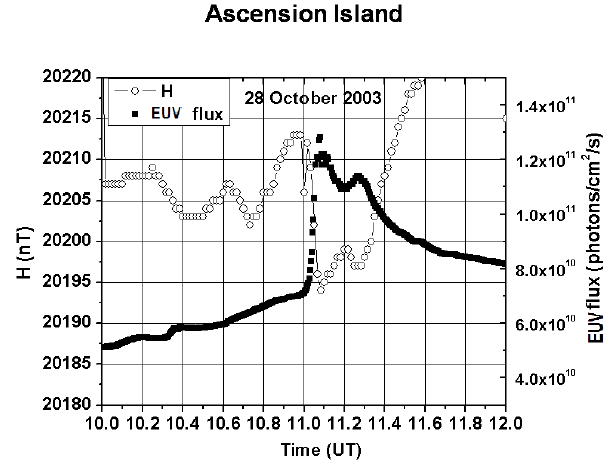
Fig. 6c. The temporal variations of EUV flux and magnetic filed ( H ) at the station of Ascension Island (14 ◦ E) on 28 October